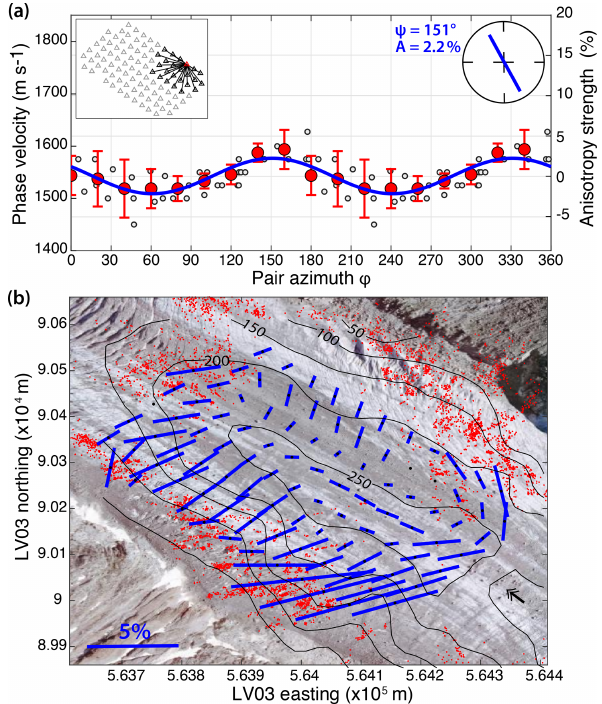
Figure 6. (a) Azimuthal variation in phase velocities measured at one node (red triangle in the inset map). White dots are the phase velocity measurements obtained for different azimuths φ that are defined by the station pair orientation. To avoid spatial averaging, we only consider subarrays of 250m aperture around the target node at the center as described by black triangles in the inset map. Red dots are phase velocities averaged in 20 ◦ azimuth bins. The thick blue curve is the best fit for the 2 φ azimuthal variation in the aver- aged velocity measurements in red. Fast-axis angle and anisotropy strength are indicated in the top right corner circle. (b) Map of fast- axis direction and amplitude of anisotropy measured at 25Hz, su- perimposed on an orthophotograph (© IGN France). Locations of icequakes active for 7d are plotted in red dots to highlight the ori- entations of surface crevasses. Basal topography contour lines are indicated every 50m. The black arrow indicates ice flow